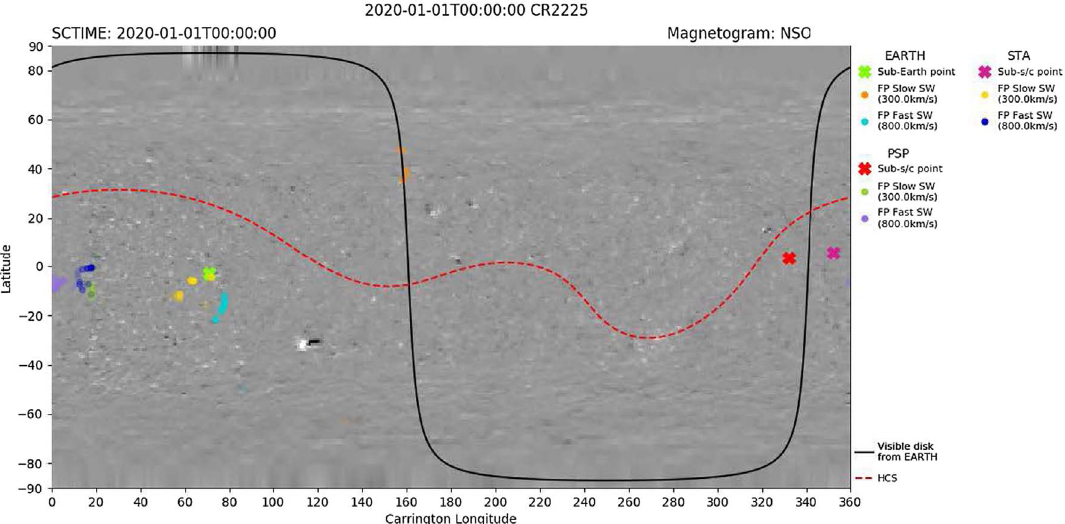
Fig. 13. Output from the Magnetic connectivity tool showing, superimposed on some Carrington map, the expected locations of the Earth, Parker Solar Probe (PSP), and Stereo A (STA), for slow and fast solar wind.